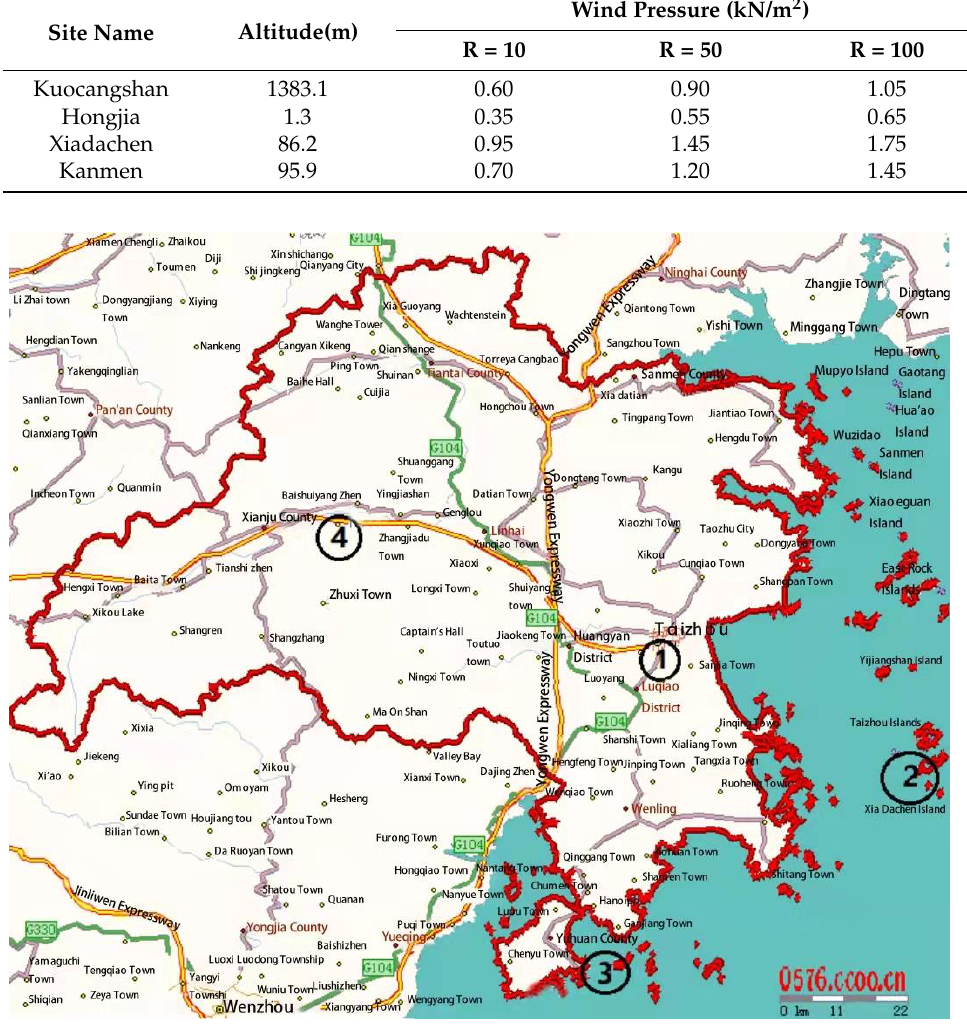
Figure 1. The reference wind pressure sites for Taizhou in the Load code for the design of building structures (GB50009-2012) . Note: The circled numbers are the locations with a specified reference wind pressure in GB50009-2012. ➀ —Hongjia; ➁ —Xiadachen; ➂ —Kanmen; ➃